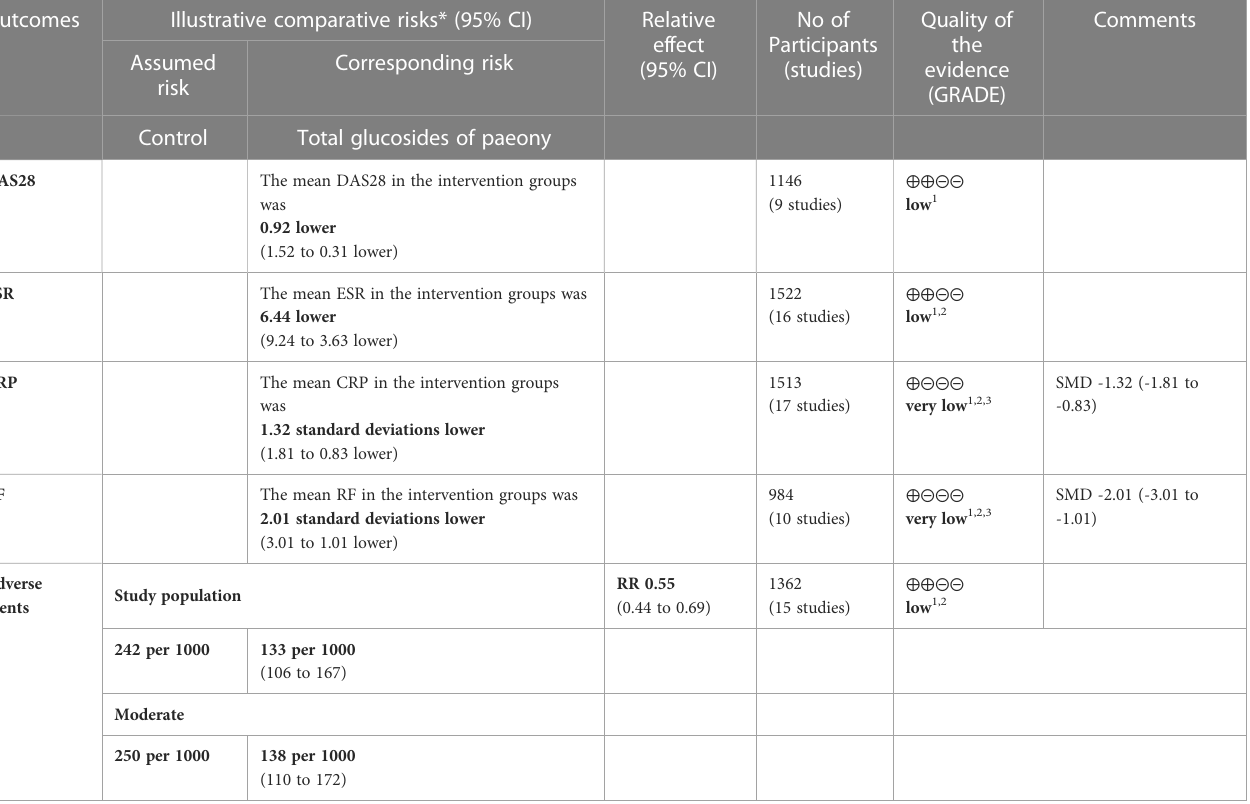
TABLE 4 The evidence quality of total glucosides of